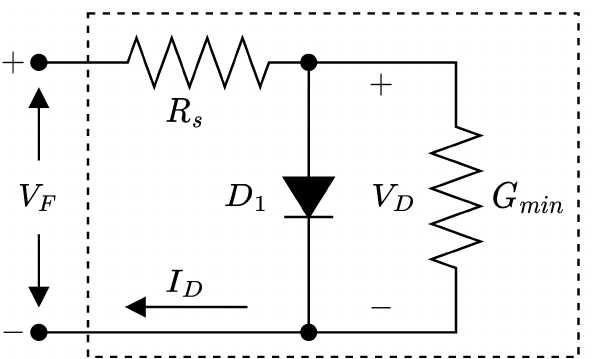
Figure 11. Circuit schematic of the SPICE large-signal diode model (LSDM). Developed from [26]. The current-voltage relationship of the SPICE LSDM is defined mathematically by Equations (1)–(4). The following definitions relate specifically to diode D 1 : V D represents the diode voltage, B V represents the reverse breakdown voltage, I S represents the satura- tion current, N represents the emission coefficient, V t represents the thermal voltage